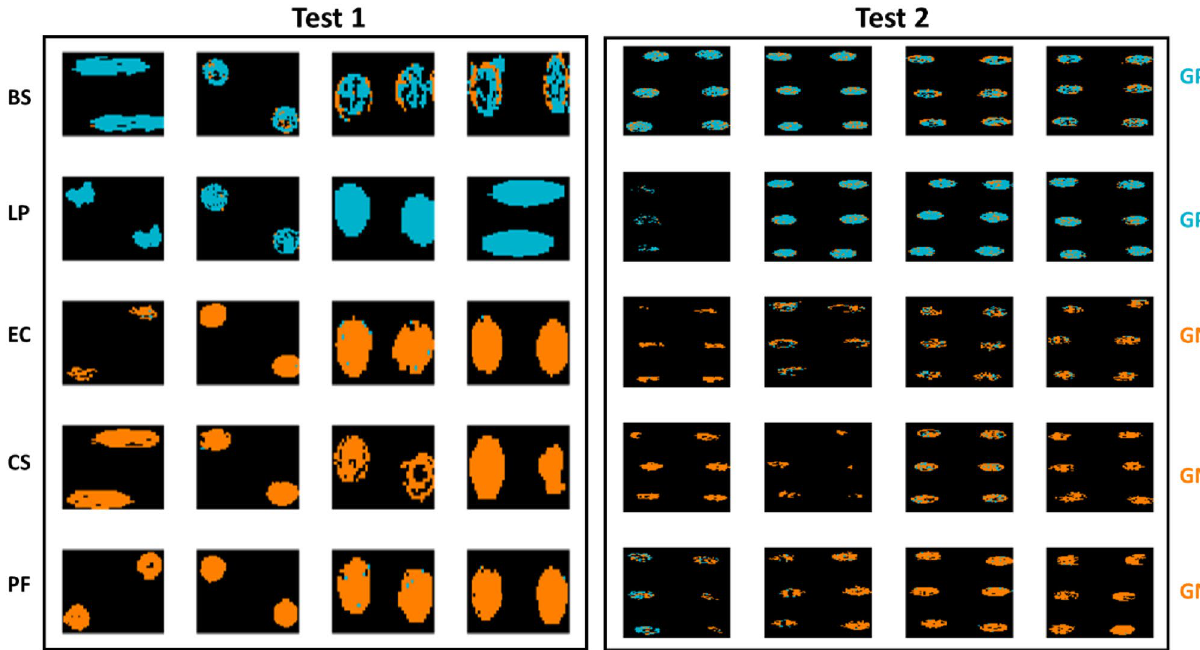
Figure 10. Classification maps for samples in the test set (reps 6, 9, 12, and 16) obtained from the best pixel- level PCA-LSTM VNIR/SWIR model for GP/GN classification. Pixels classified as GP/GN are shown in blue or orange respectively. Each replicate has two drops. BS: Bacillus subtilis ; LP: Lactobacillus plantarum ; EC: Escherichia coli , CS: Cronobacter sakazakii ; PF: Pseudomonas